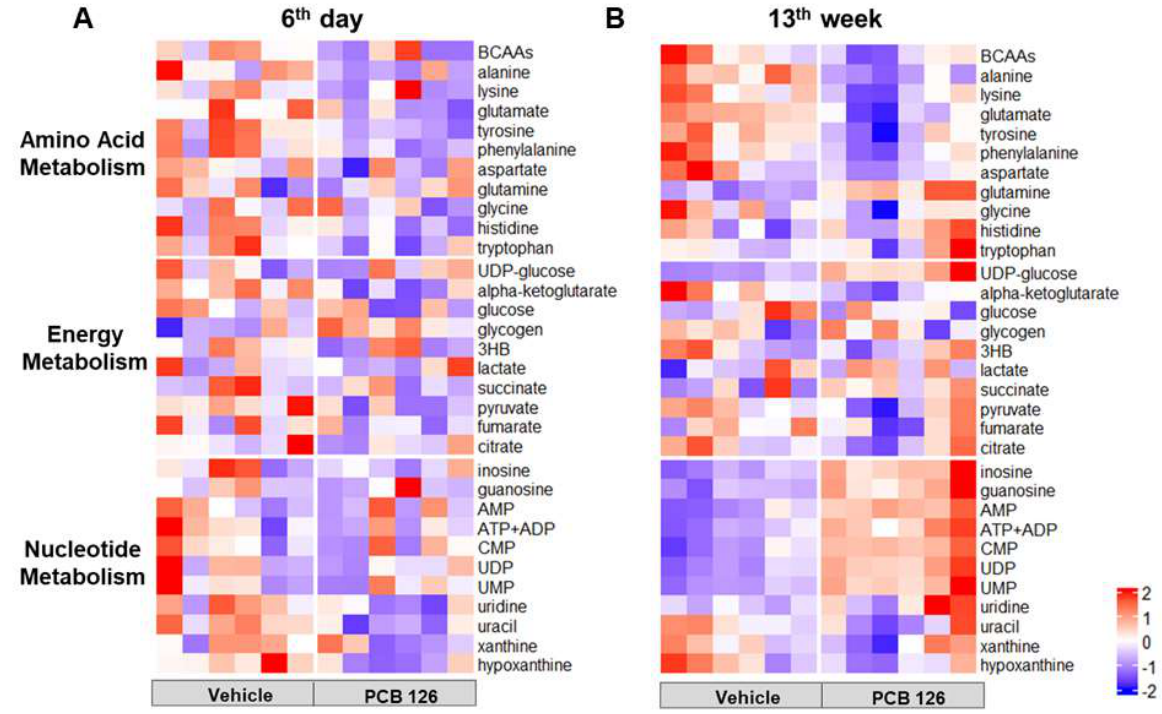
Figure 2. Effects of early life PCB 126 exposure on liver global metabolism. Heat map representation of relative content of liver hydrophilic metabolites obtained from 1 H NMR analysis from mice with vehicle or PCB 126 exposure at the 6th day ( A ) or 13th week ( B ). n = 6 per group. BCAAs, branched-chain amino acids; UDP-glucose, uracil-diphosphate glucose; 3HB, 3-hydroxybutyric acid; AMP, adenosine monophosphate; ADP, adenosine diphosphate; ATP, adenosine triphos- phate; CMP, cytidine 5′-monophosphate; UDP, uridine 5′-diphosphate; UMP, uridine monophos- phate.